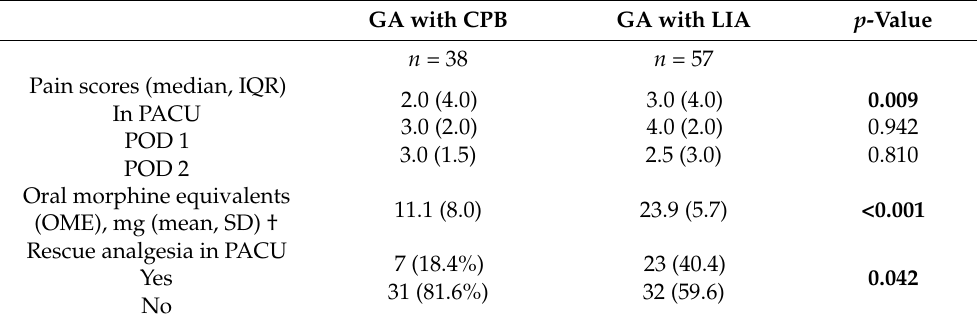
Table 4. Comparison of pain scores and opioid requirements of patients who received a cervical plexus block alone versus those who received general anesthesia with local infiltration